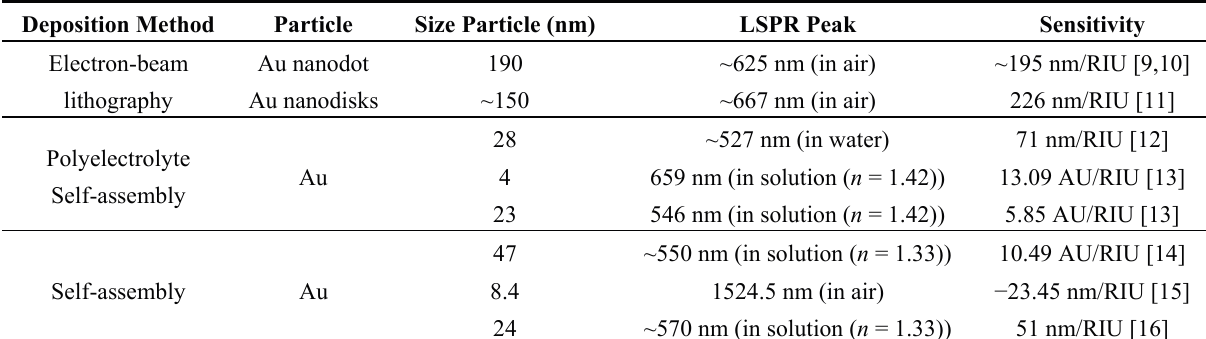
Table 1. Deposition methods used to fabricate optical fiber sensors based on localized surface plasmon resonance